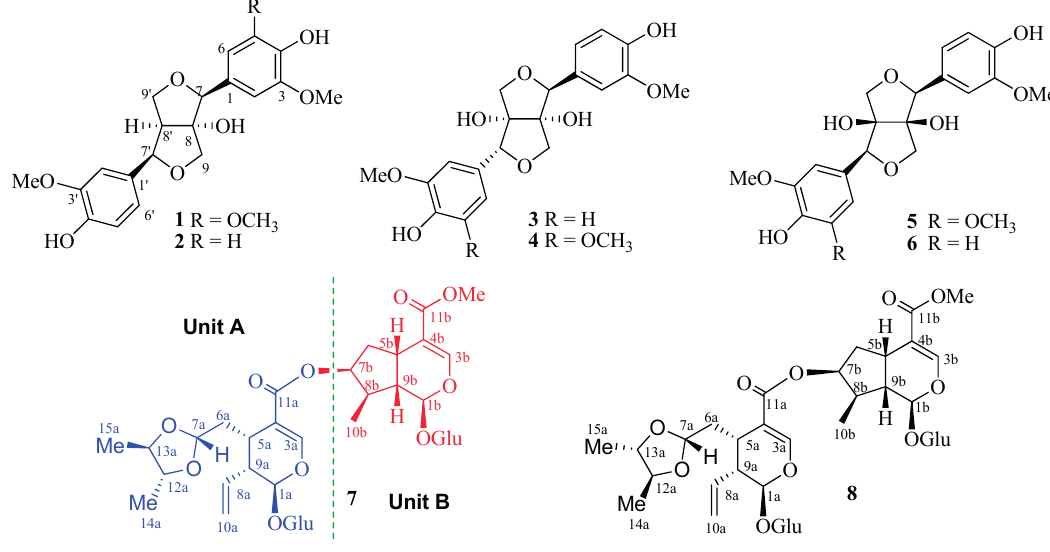
Figure 1. Chemical Structures of Compounds 1 – 8